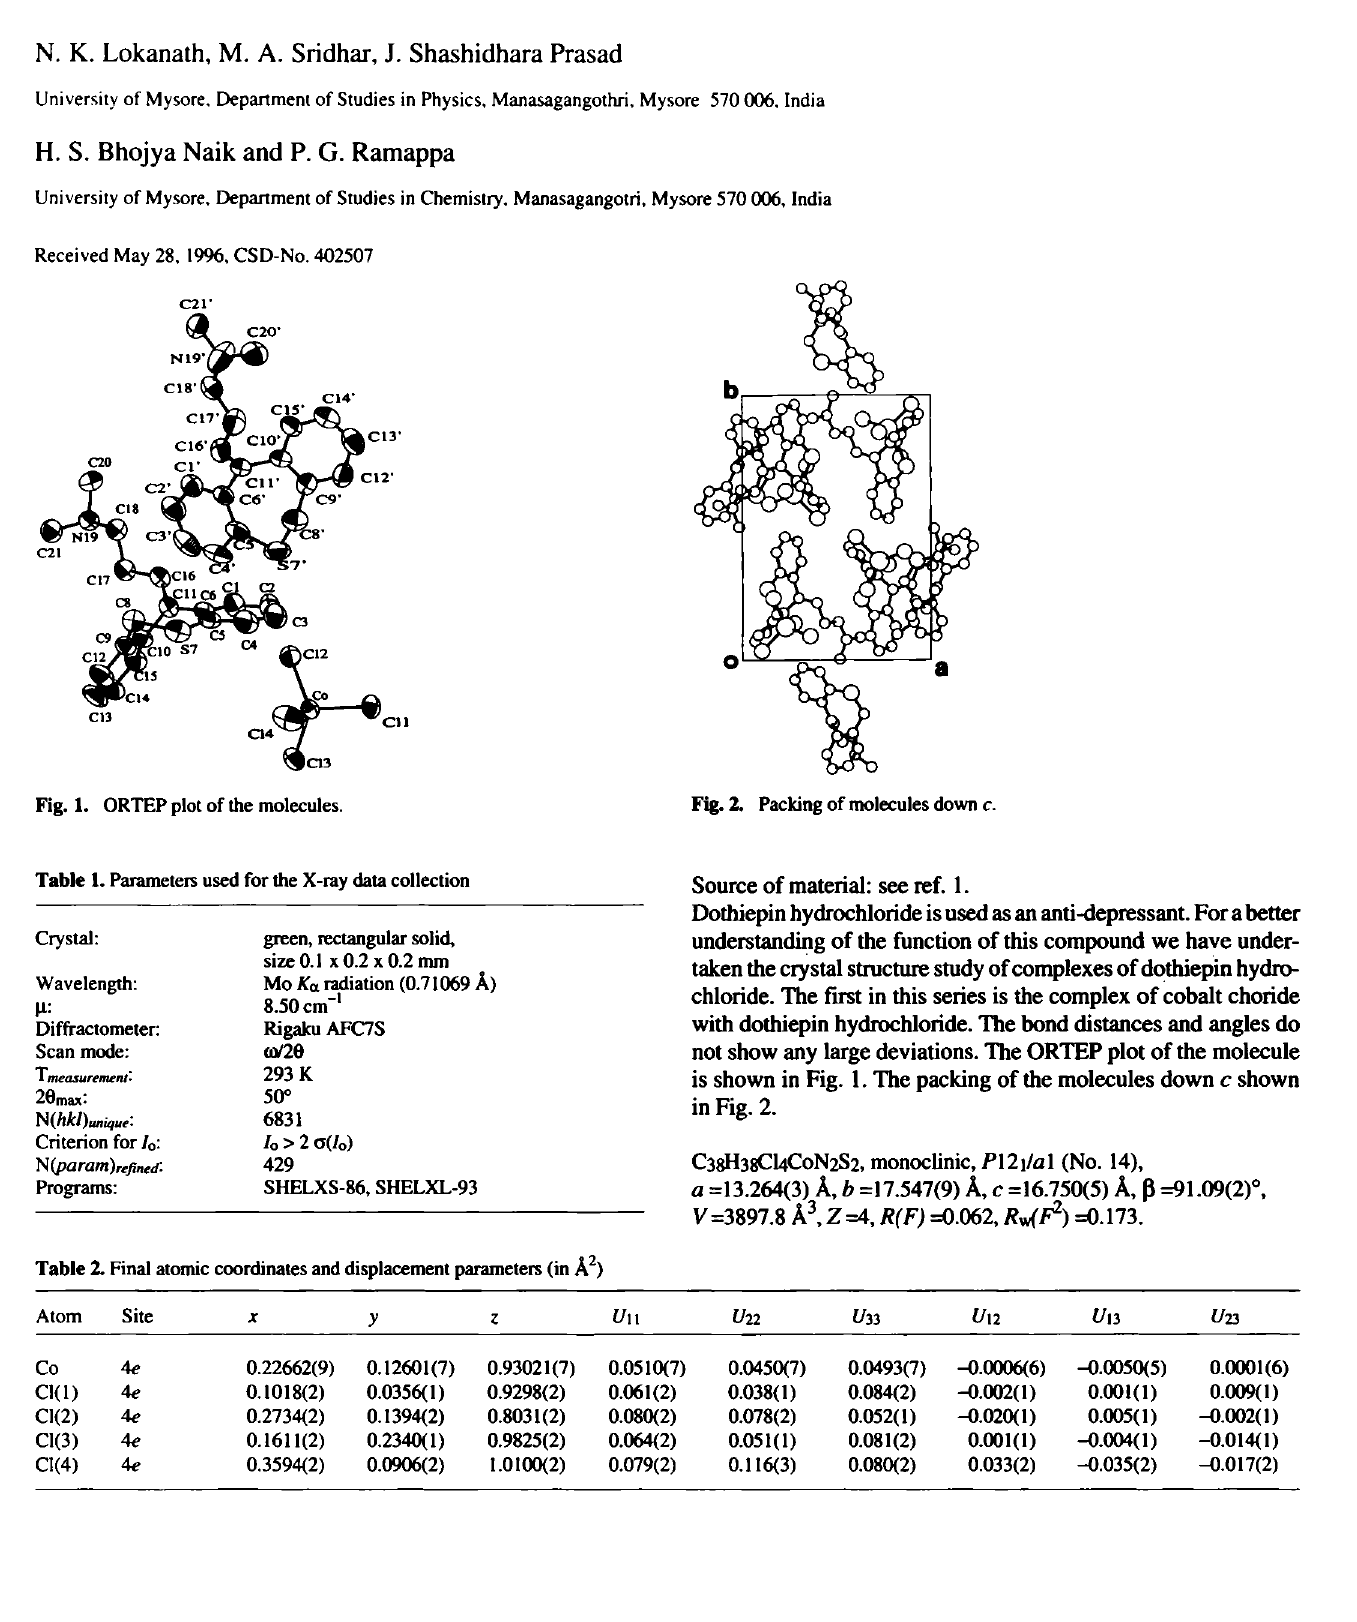
Source of material: see ref.